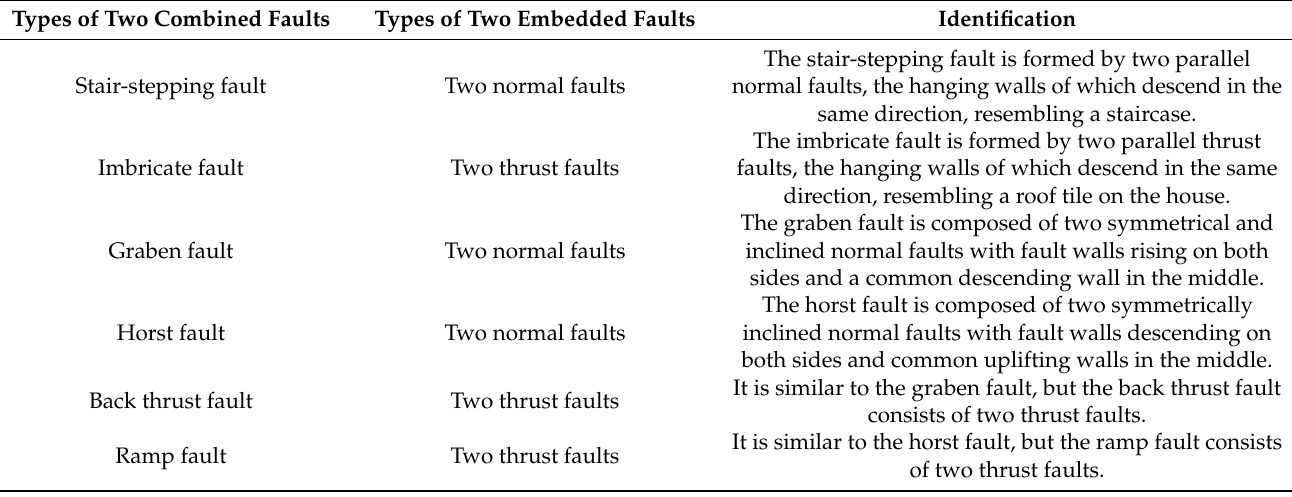
Table 1. The detailed identification of two combined faults (as referred to HU